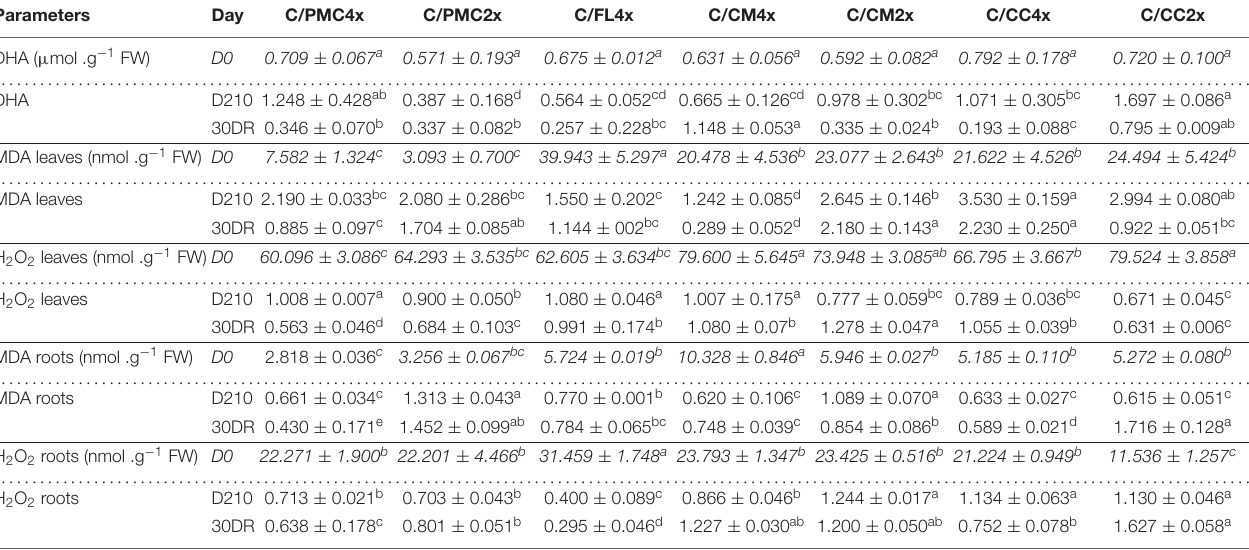
TABLE 6 | Oxidative markers of the seven scion/rootstock combinations after 210 days of nutrient deficiency (D210) and 30 days of recovery (30DR).